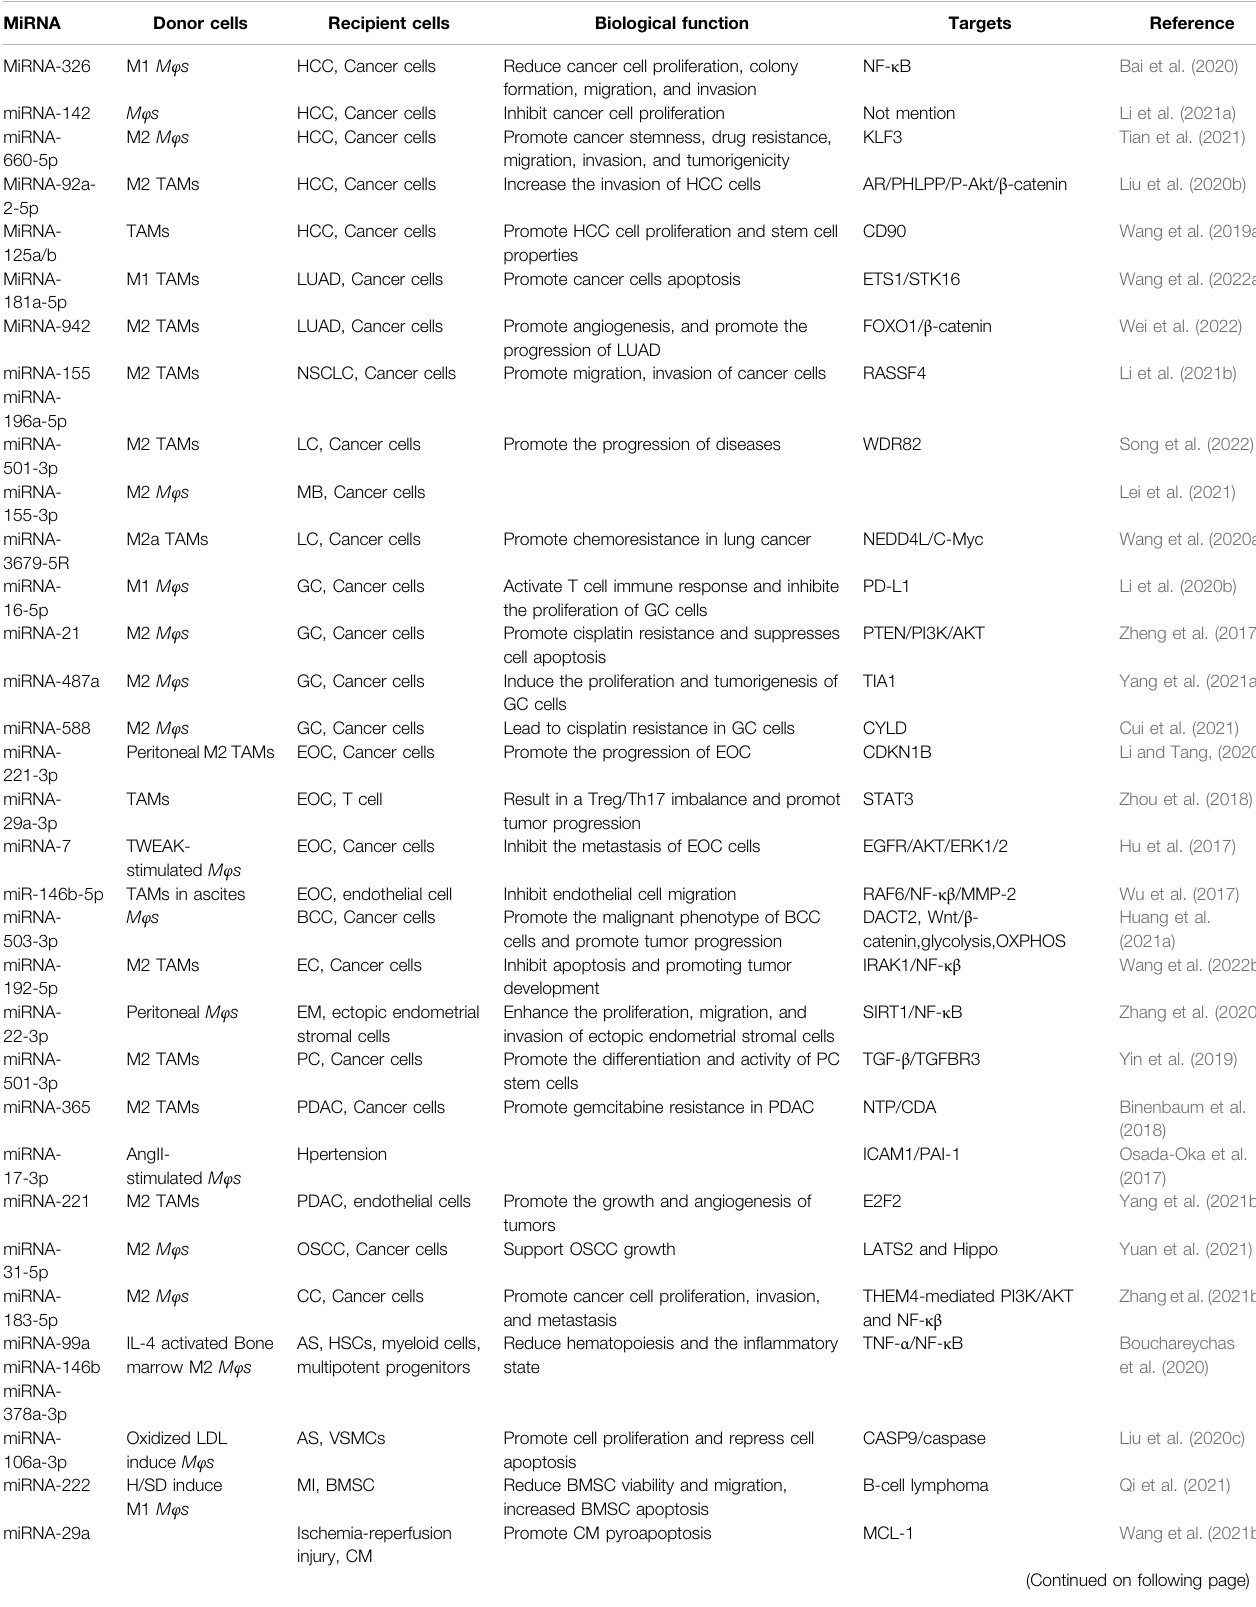
TABLE 3 | Other miRNA exerts different biological